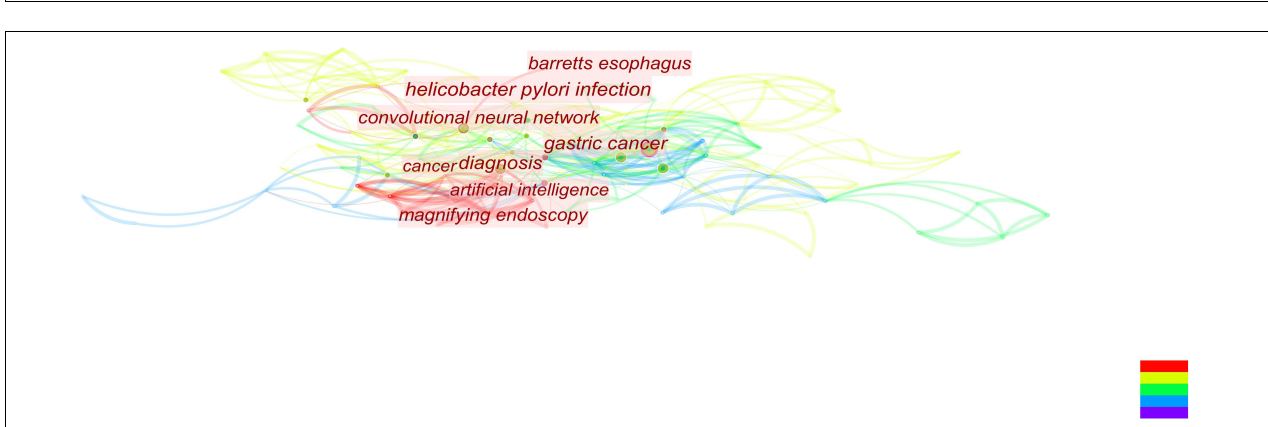
FIGURE 7 | According to this figure, we can see that the convolutional neural network is currently attracting a lot of attention and is closely associated with gastric cancer.